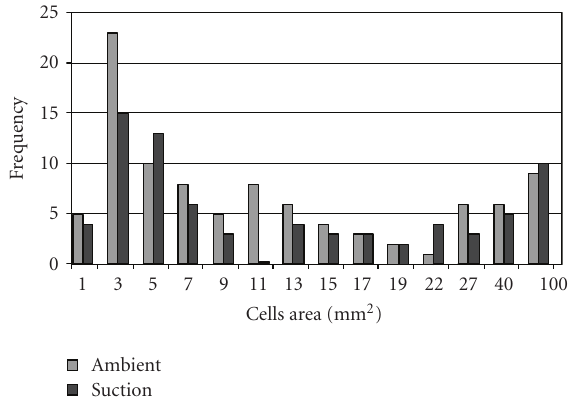
Figure 15: SEM image of SiC particles at the surface of N 2 foamed wall bubble (SM, nitrogen, ambient).